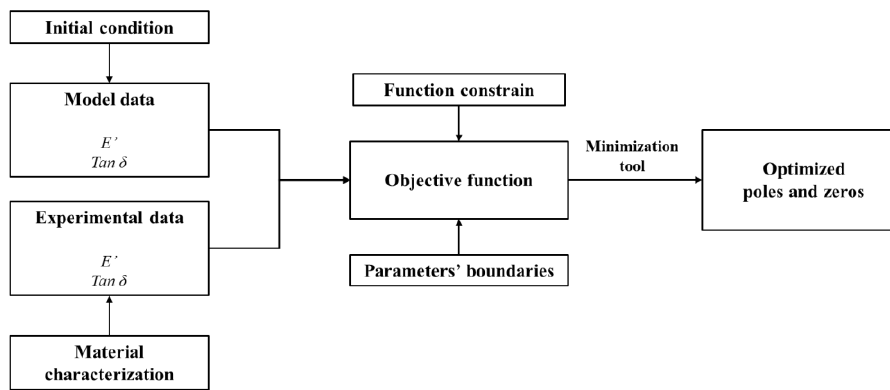
Figure 2. Constrained nonlinear optimization procedure to identify poles – zeros coefficients: func- tional scheme.